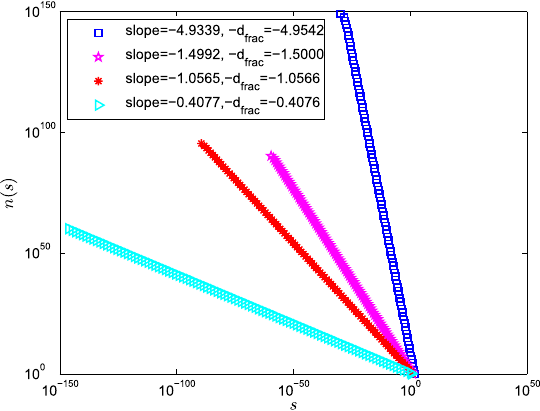
Figure 3. The log-log plot of n ( s ) versus s for different weight factor r and different copy number f